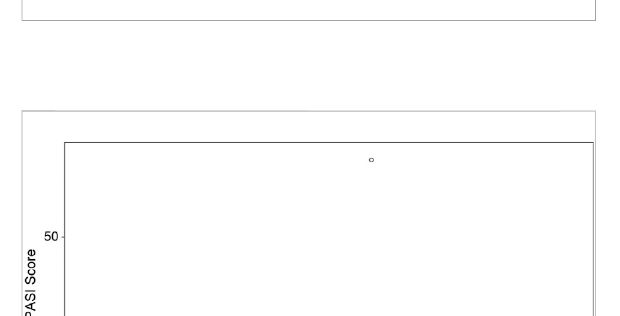
FIGURE 6 Prediction-corrected visual predictive check (pcVPC) results for population PK and PK/PD models. pcVPC from the population PK model.